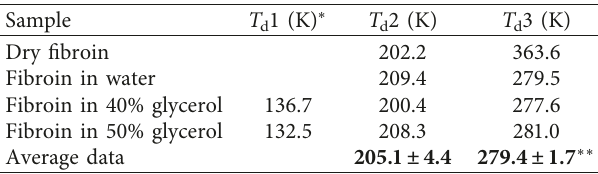
Table 1: Parameter of thermal decay curves of free radicals in fibroin at various